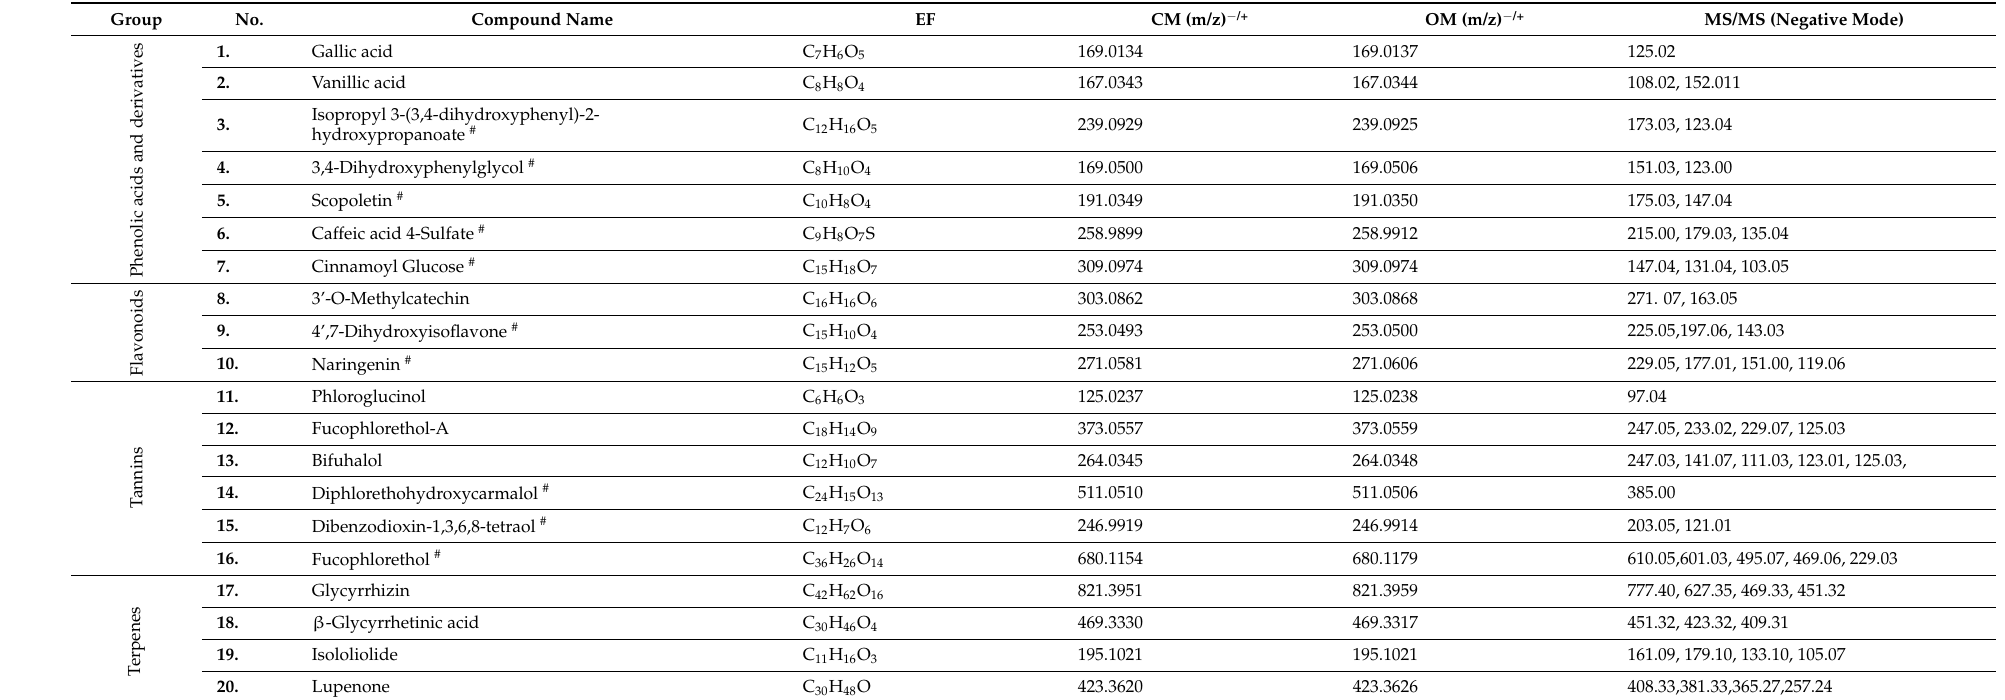
Table 5. Identified compounds of the optimized extract of Sargassum fusiforme by ESI-MS/MS.